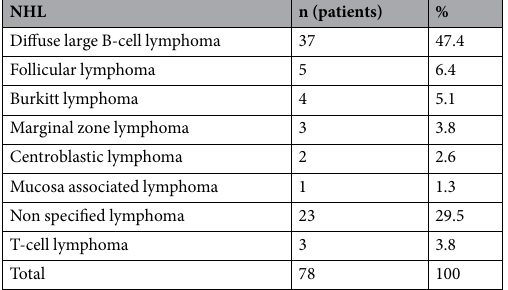
Table 2. Non-Hodgkin-lymphoma (NHL) subtypes affected the breast.